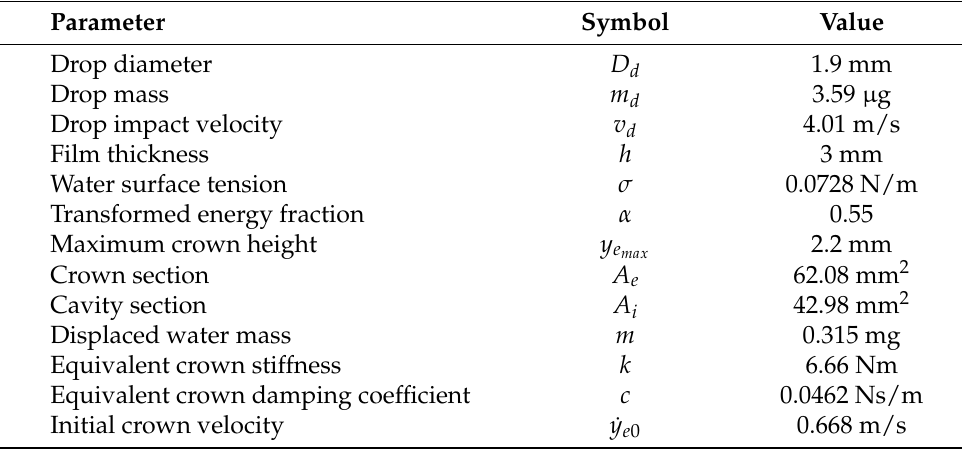
Table 3. Parameters for the computation of the force acting on the wet